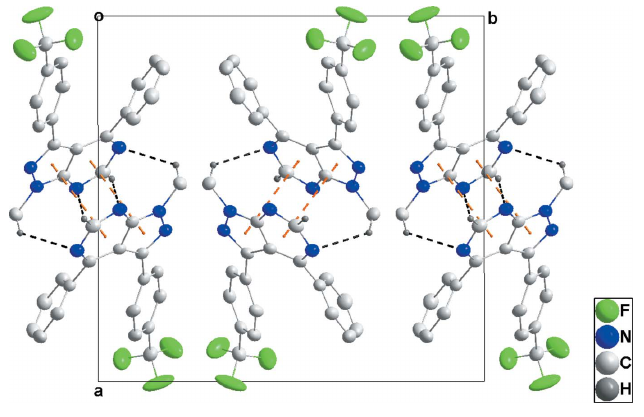
Figure 2 Detail of the stepped chain formed by C—H (cid:3)(cid:3)(cid:3) N hydrogen bonds (black dashed lines) and offset (cid:2) -stacking interactions (orange dashed lines).